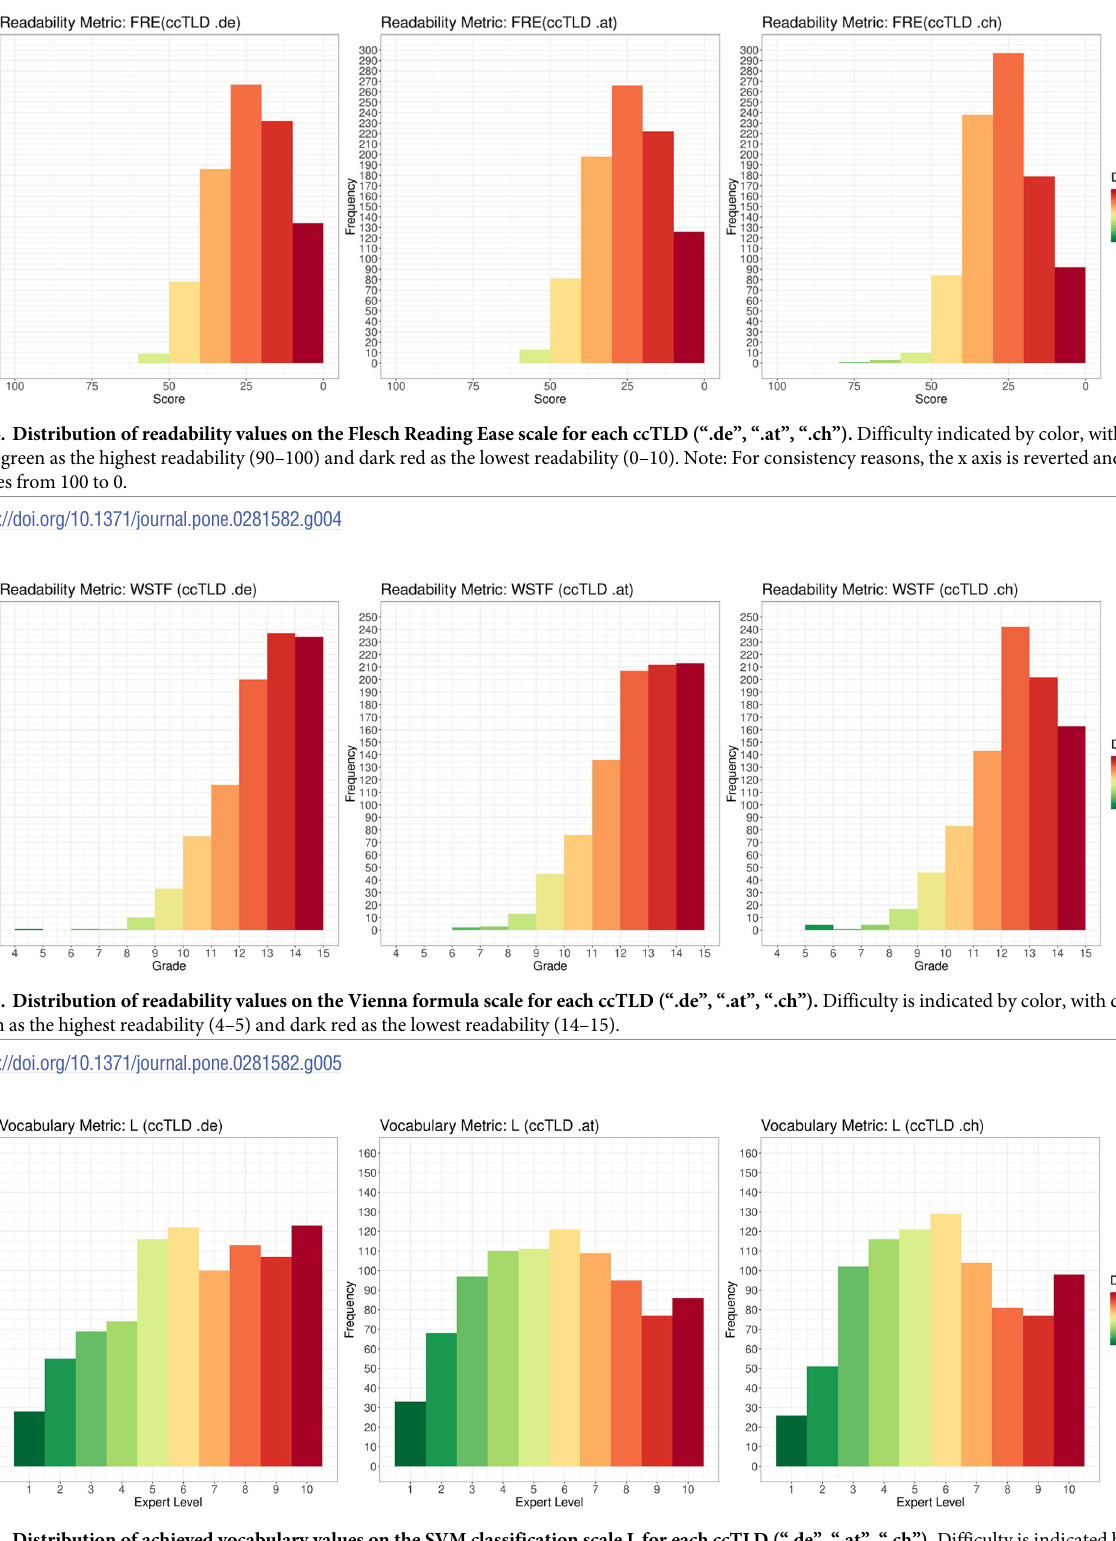
PLOS ONE | https://doi.org/10.1371/journal.pone.0281582 February 10,